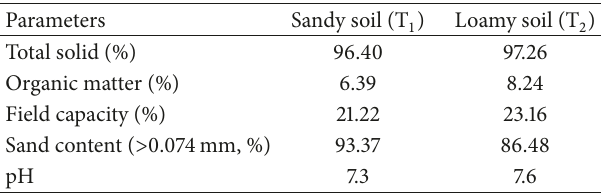
Table 1: Characteristics of soils used in this